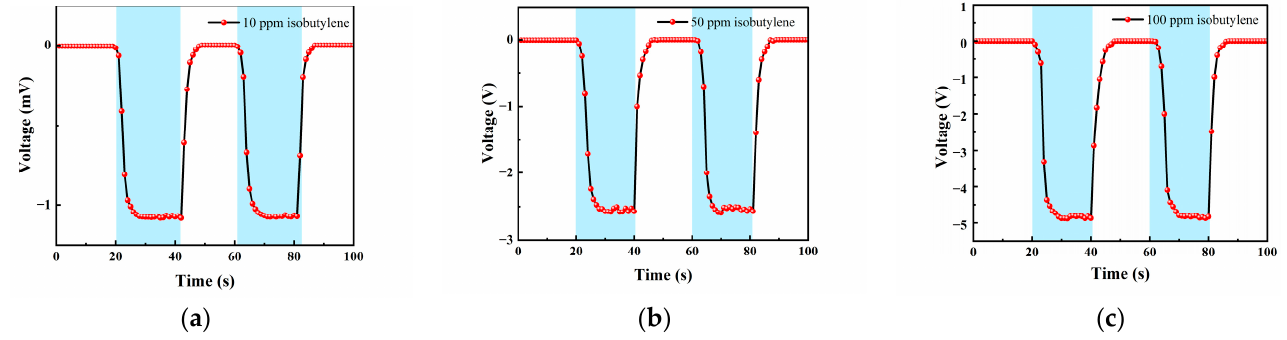
Figure 11. Different isobutylene gas concentration test: ( a ) A 10 ppm isobutylene-Ar cycle test; ( b ) a 50 ppm isobutylene-Ar cycle test; and ( c ) a 100 ppm isobutylene-Ar cycle test.